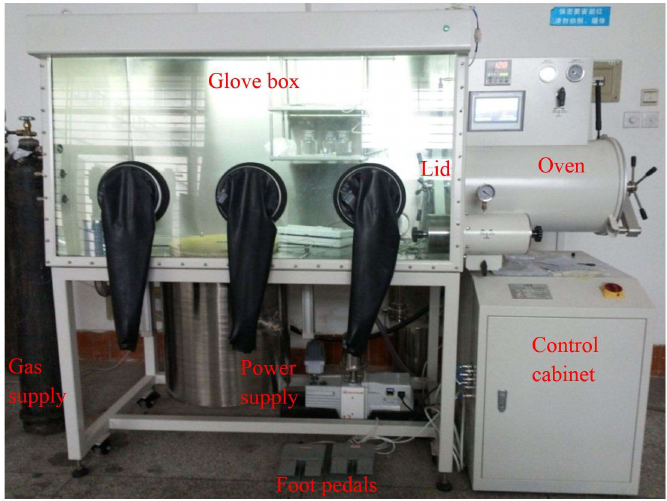
Figure 1. Photograph of the nitridation setup.